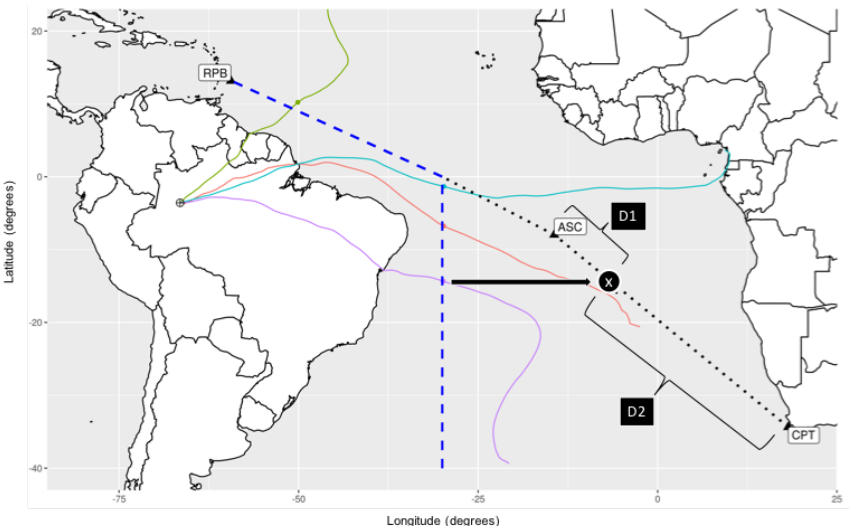
Figure 4. Air-mass back-trajectories method scheme. Blue dashed line is the Virtual Limit. Green, red, cyan and purple are examples of air-mass back-trajectories. D1 and D2 are the distances between the projected (black arrow) position “X” and the NOAA global stations, using the purple air-mass back-trajectory as an illustration of the AMBaM BKG